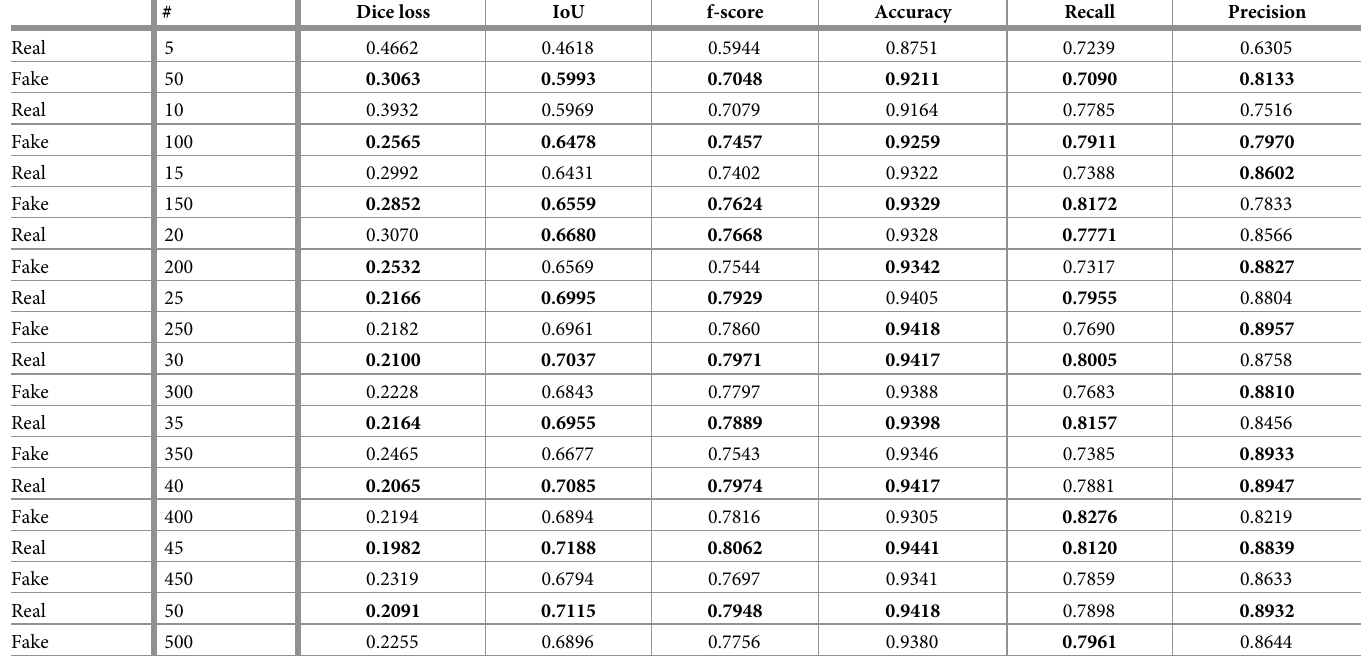
Table 3. Real versus fake comparisons for small datasets after applying the style transfer method with a 1: 1000 ratio for fake data.